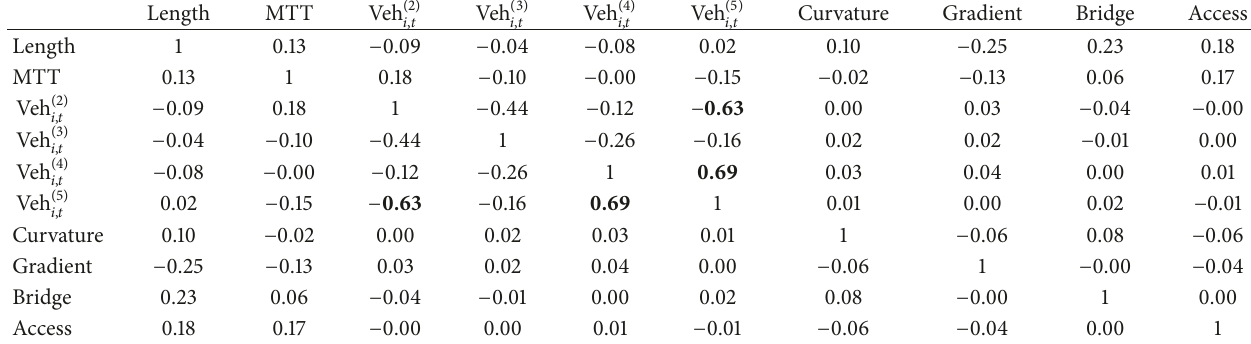
Table 3: Pearson correlation coefficients between explanatory